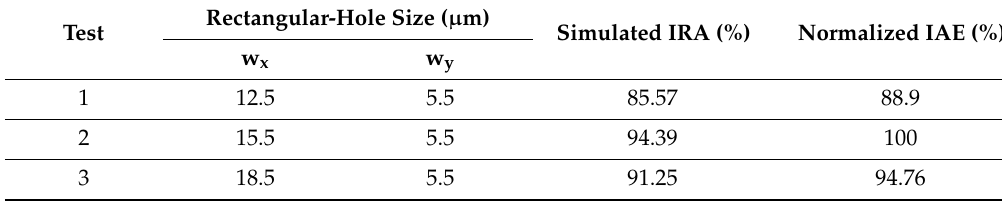
Figure 7. Normalized IAEs normalized by the maximum of them with the target temperature for three proposed thermopiles and that without structure. Table 2. Rectangular-hole sizes of three proposed SA type patterns with ρ = 2.5 µ m for the trial thermopiles, their simulated IRAs, and normalized